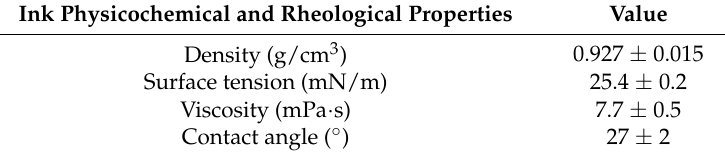
Table 3. Relevant physicochemical properties of a 0.2 M (in yttrium) SDP-Y 2 O 3 precursor ink ([DEA]/[Y] ratio of 4.5) with a 10% ( v / v ) of UV photosensitive varnish. Viscosity measurement was carried out at a shear rate of 2880 s − 1 and 25 ◦ C. The contact angle was measured at room temperature on top of unpolished SS from